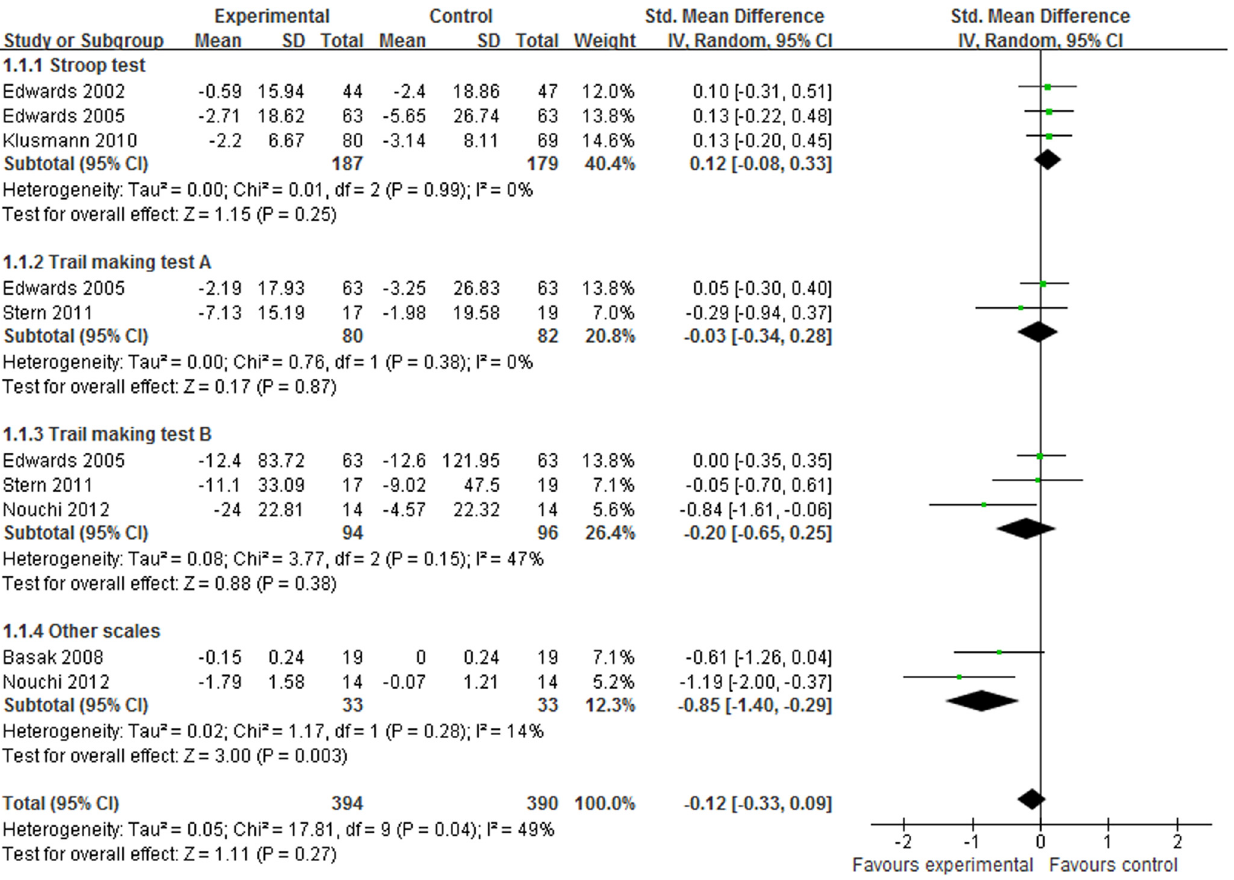
Fig 5. Forest plot of the effect of computer-based cognitive programs in executive function.